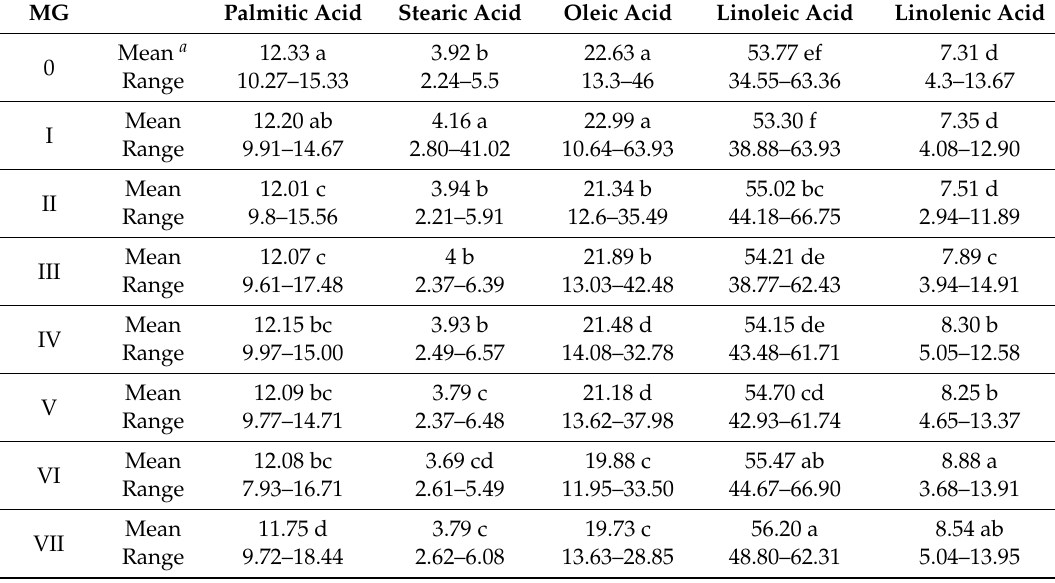
Table 3. Fatty acid composition (%) in soybean seeds from di ff erent maturity groups (MGs) across two